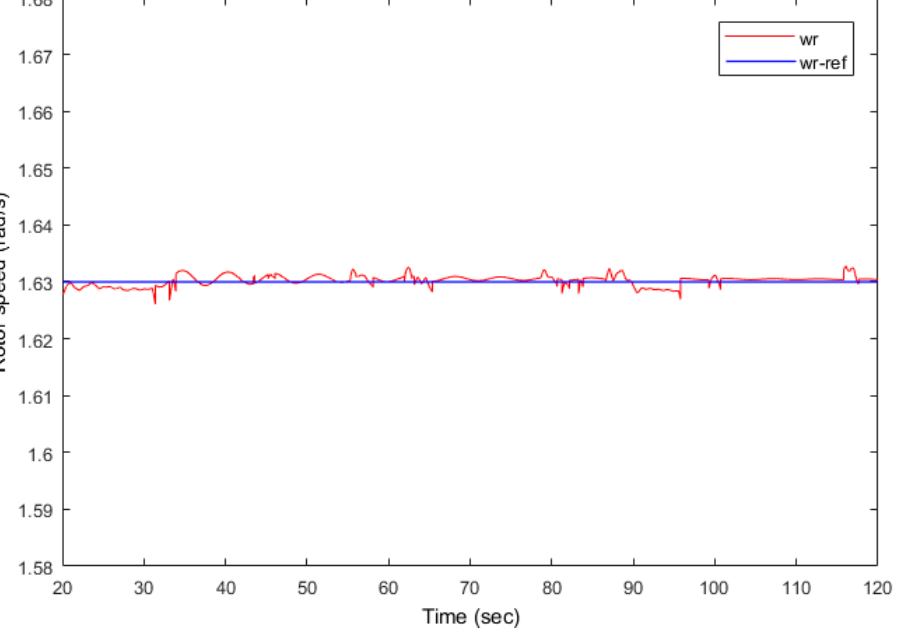
Figure 15. Steady-state rotor speed tracking of the wind turbine in Chapman Ranch.